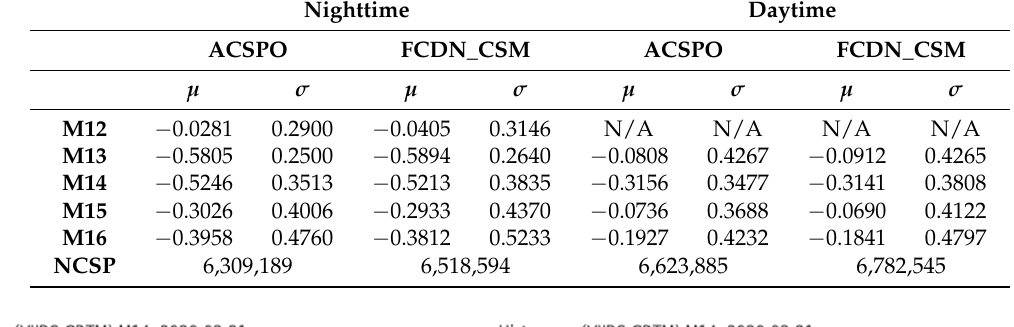
Figure 2. Global distribution of the O-M biases on 02/21/2020 for VIIRS M14 (Top), M15 (middle), and M16 (bottom), using FCDN_CSM as clear-sky identification for both daytime (left) and nighttime (right).